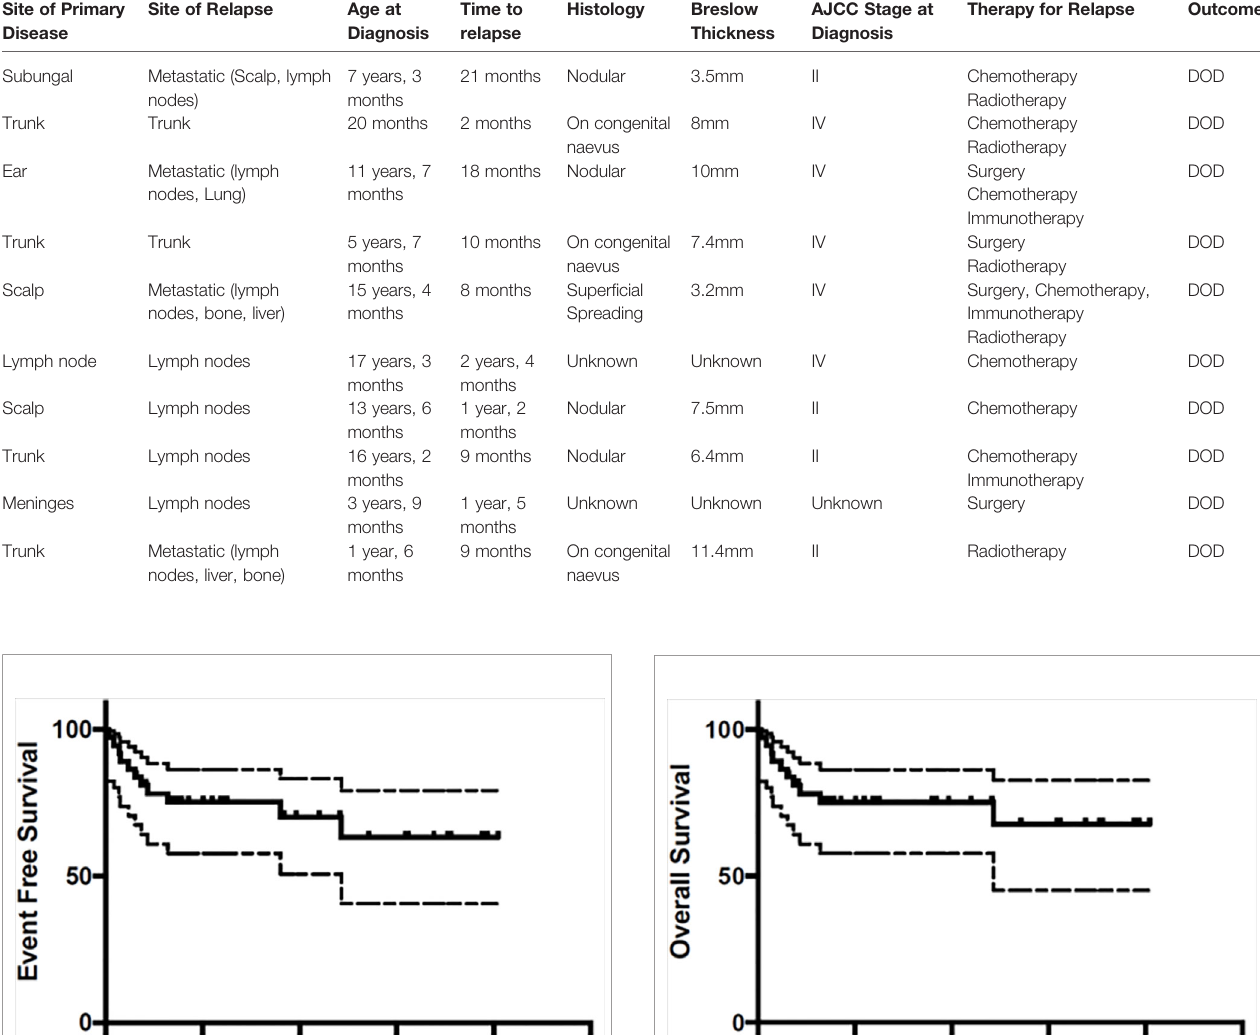
TABLE 3 | Relapse characteristics.